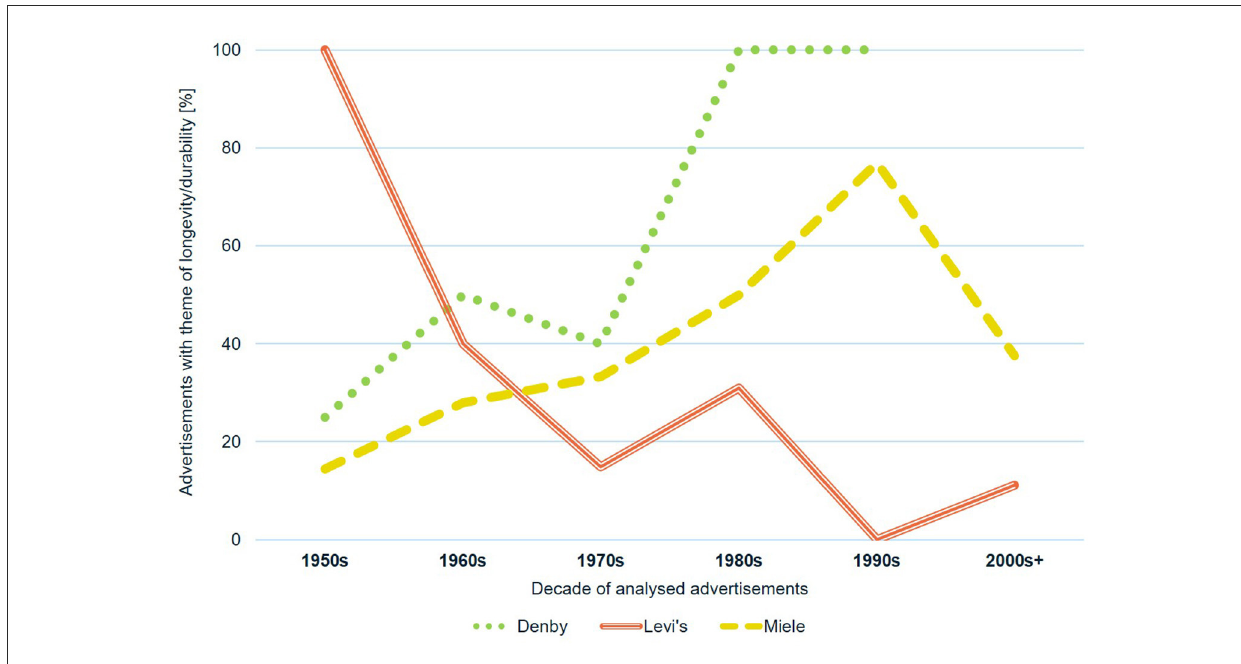
FIGURE1 Presence of longevity/durability theme in advertisements (in